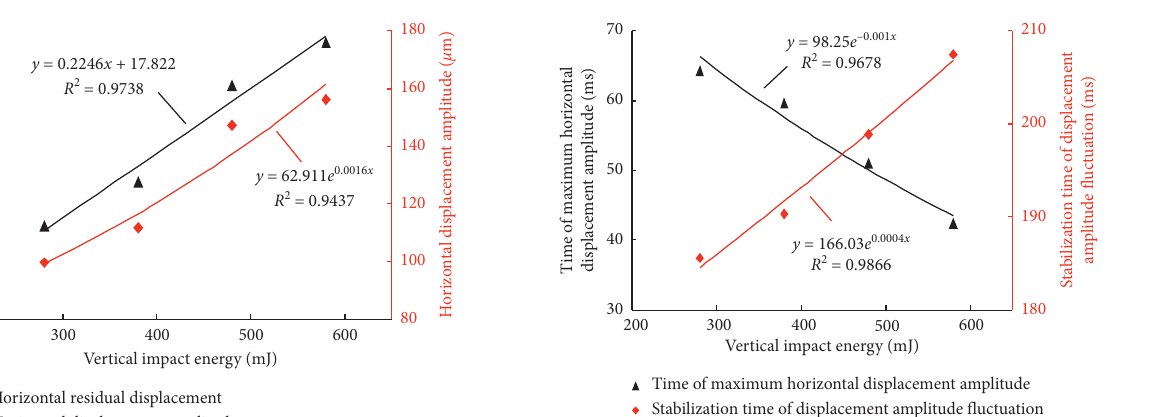
Figure 7: Relation curve between the vertical impact energy and the time of the maximum horizontal displacement amplitude and stabilization time of displacement amplitude fluctuation.